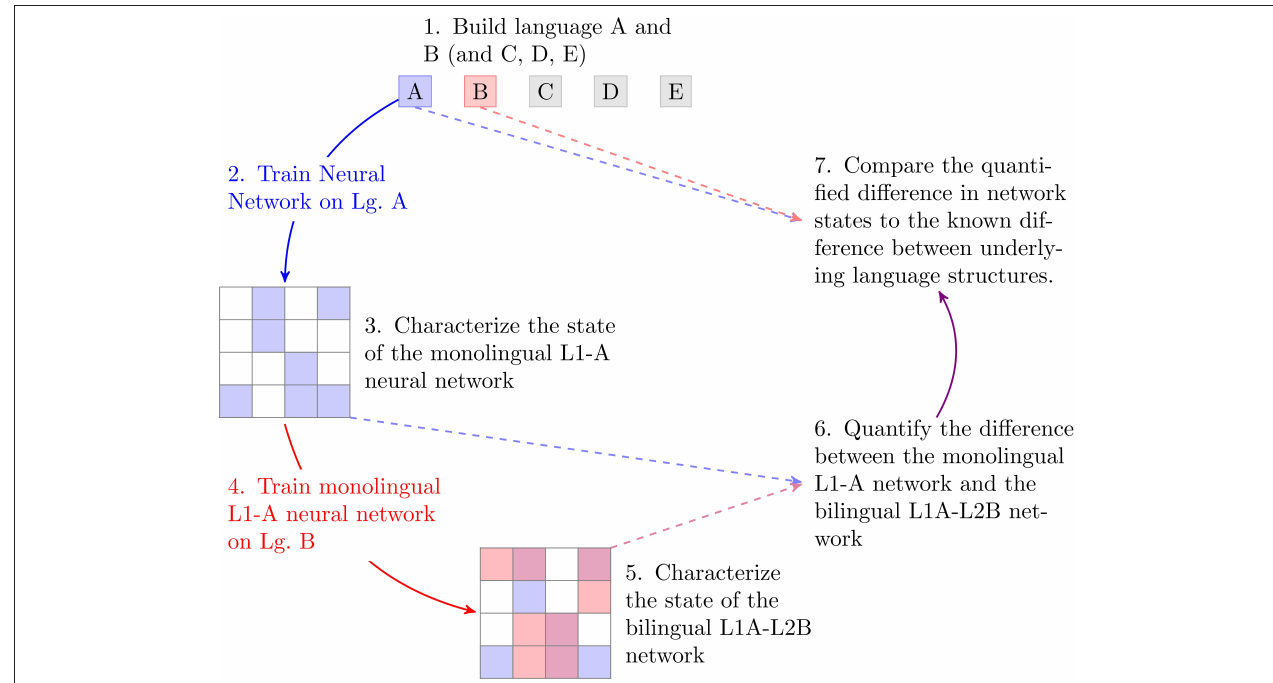
FIGURE 1 | Summary of the process for generating learnability metrics across artificial language pairs.